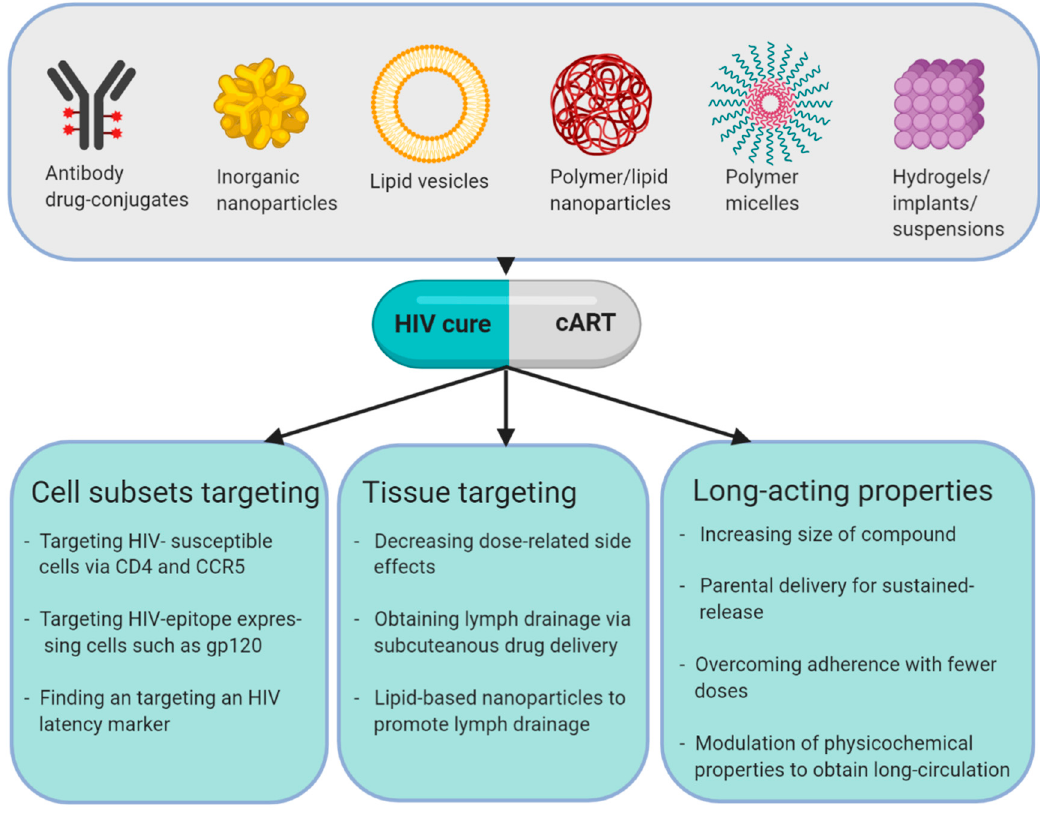
Figure 1. Examples of types of nanotherapy and their application in HIV treatment and cure. Created with